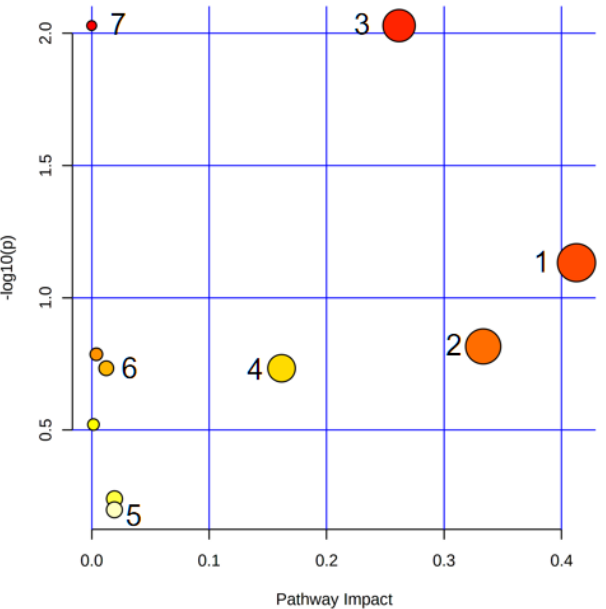
Figure 8. Overview of the metabolic pathway analysis. 1. Arachidonic acid metabolism; 2. Alpha-linolenic acid metabolism; 3. Glycerophospholipid metabolism; 4. Retinol metabolism; 5. Steroid hormone biosynthesis; 6. Glycerolipid metabolism; 7. Biosynthesis of unsaturated fatty acids.